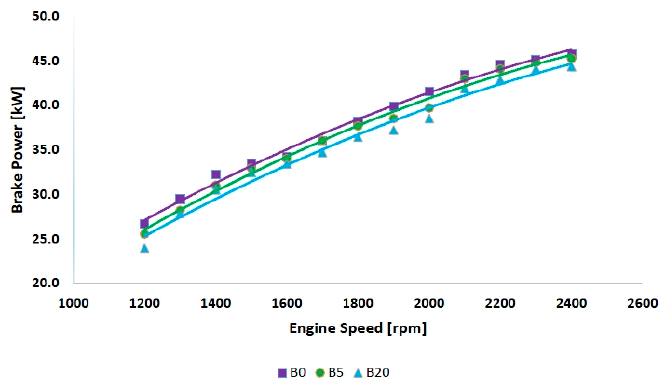
Figure 6. Variation of brake power with speeds.